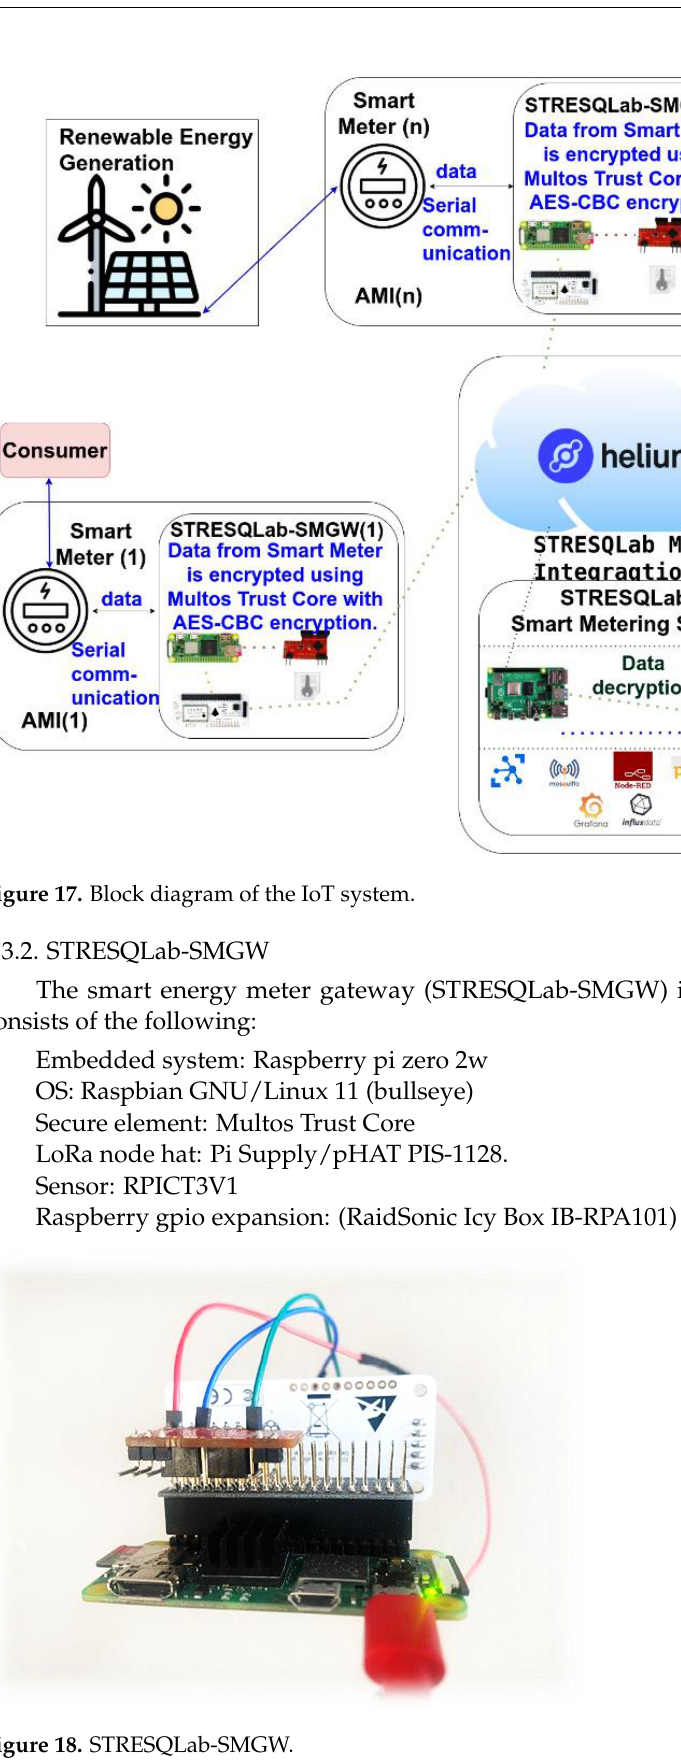
Figure 18. STRESQLab-SMGW.